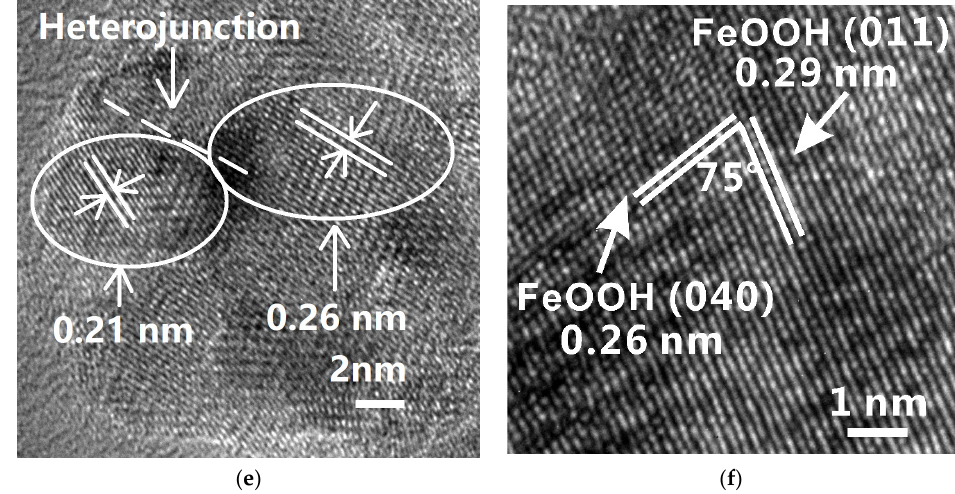
Figure 5. HRTEM images of ( a ) NFM LDH, ( b , c ) NFM LDH ‐ G, ( d , e ) NFM LDH/OOH, ( f ) NFM LDH/OOH ‐ G. The oxygen evolution activity of NFM LDH and its derivatives were evaluated by linear sweep voltammetry (LSV) and electrochemical impedance spectroscopy (EIS) in 1 M KOH solution. As shown in Figure 6a,b, NFM LDH/OOH heterojunction delivers an overpotential of 449 mV at 10 mA cm − 2 , which is 25 mV lower than that of pure NFM LDH, manifesting an enhanced OER electrocatalytic activity. The incorporation of graphene into the NFM LDH and its oxyhydroxide heterojunction further lowers the overpotential to, respectively, 360 mV and 338 mV, which are both smaller than that of commercially used RuO 2 catalyst (373 mV), suggesting a substantial improvement in electrocatalytic perfor ‐ mance. The comparison of the overpotential for the prepared NFM LDH ‐ based electrocat ‐